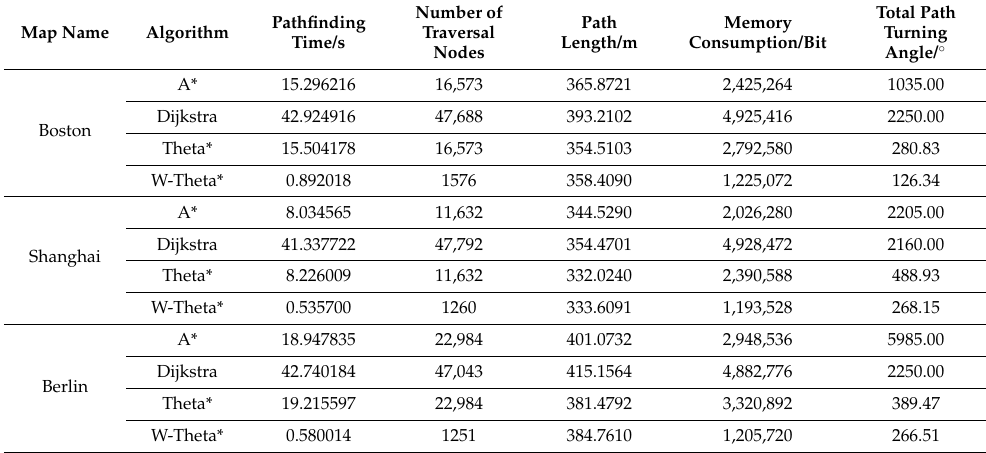
Table 4. Experimental data sheet for various algorithms on City maps.